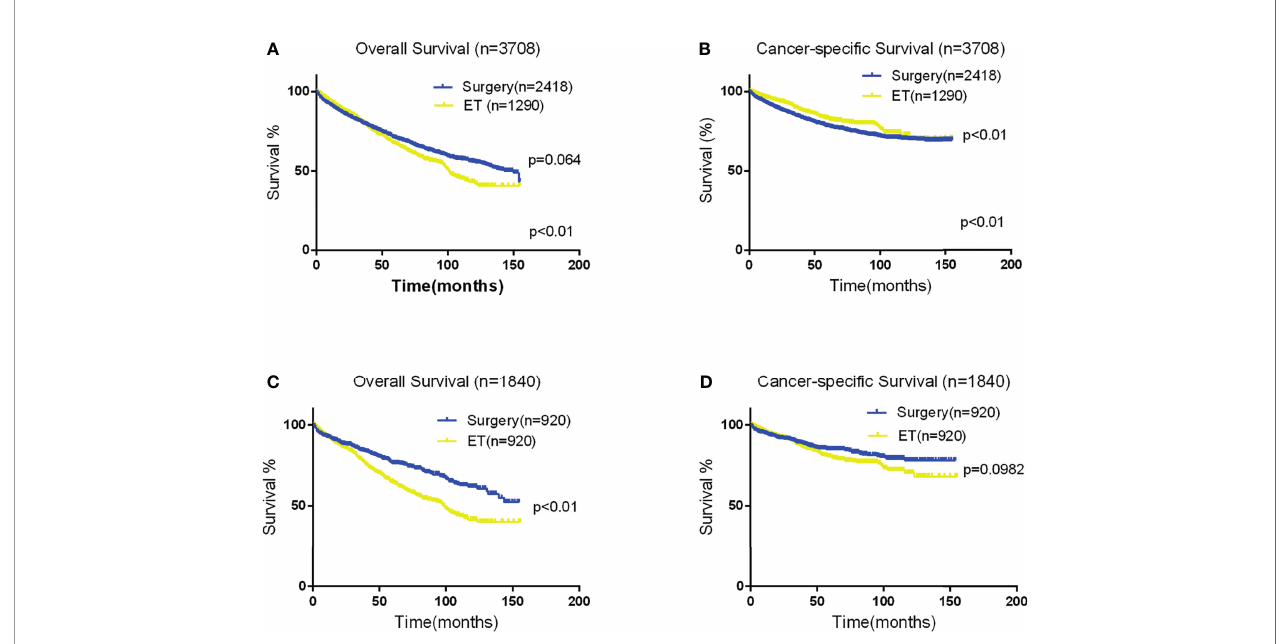
FIGURE 1 | Kaplan-Meier curves for OS and CSS. Panels (A, B) depict the overall and CSS of the Two groups in the original data set, and panels (C, D) depict the OS and CSS of the two group after propensity score